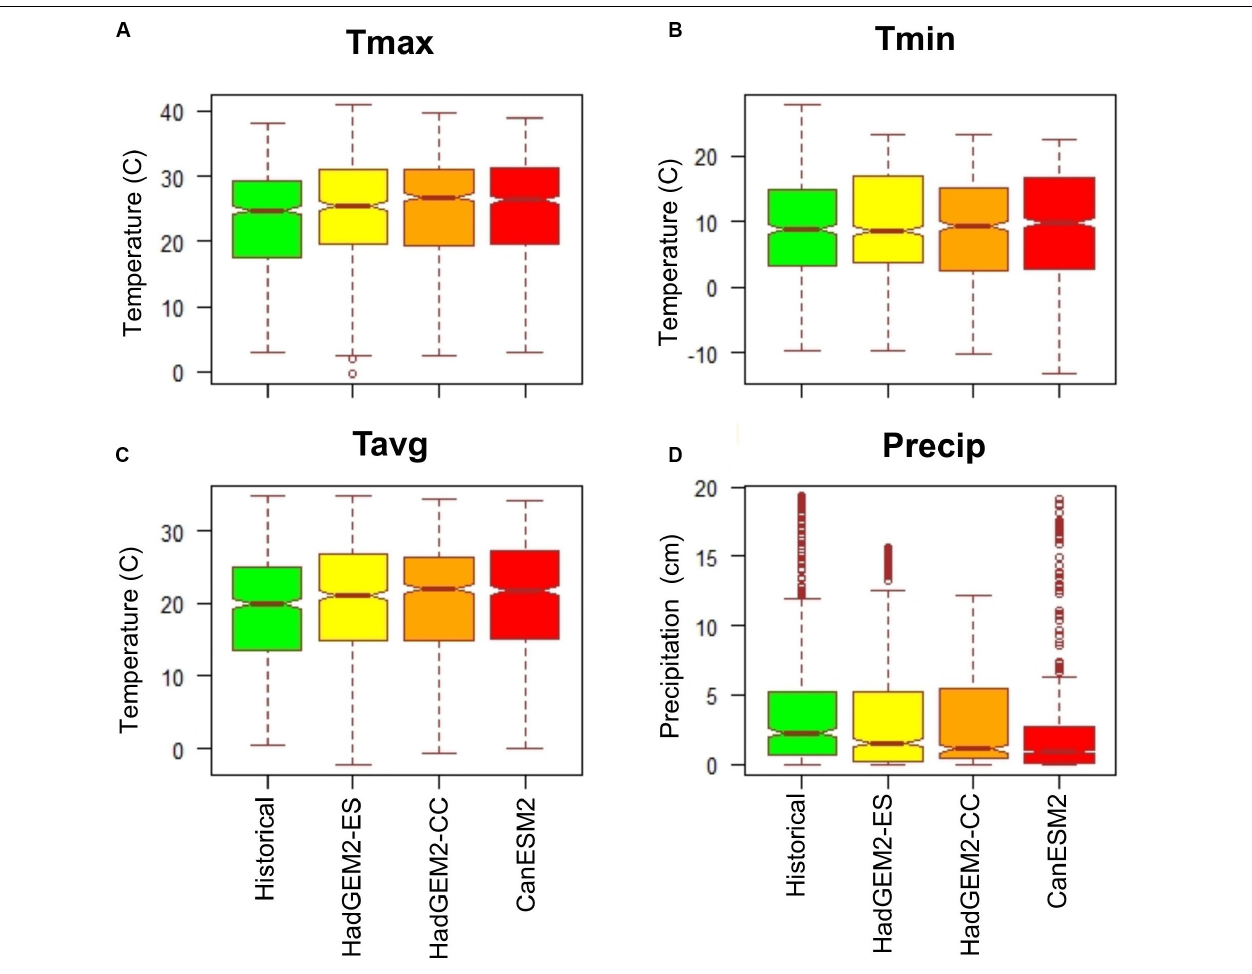
FIGURE 3 | Comparison of historical weather station and calibrated downscaled GCM outputs. Boxplot comparisons of (A) daily maximum temperature, (B) minimum temperature, (C) average temperature, and (D) precipitation. Historical data are from Coronado National Monument, Arizona. GCMs are CMIP5 models HadGEM2-ES, HadGEM2-CC, and